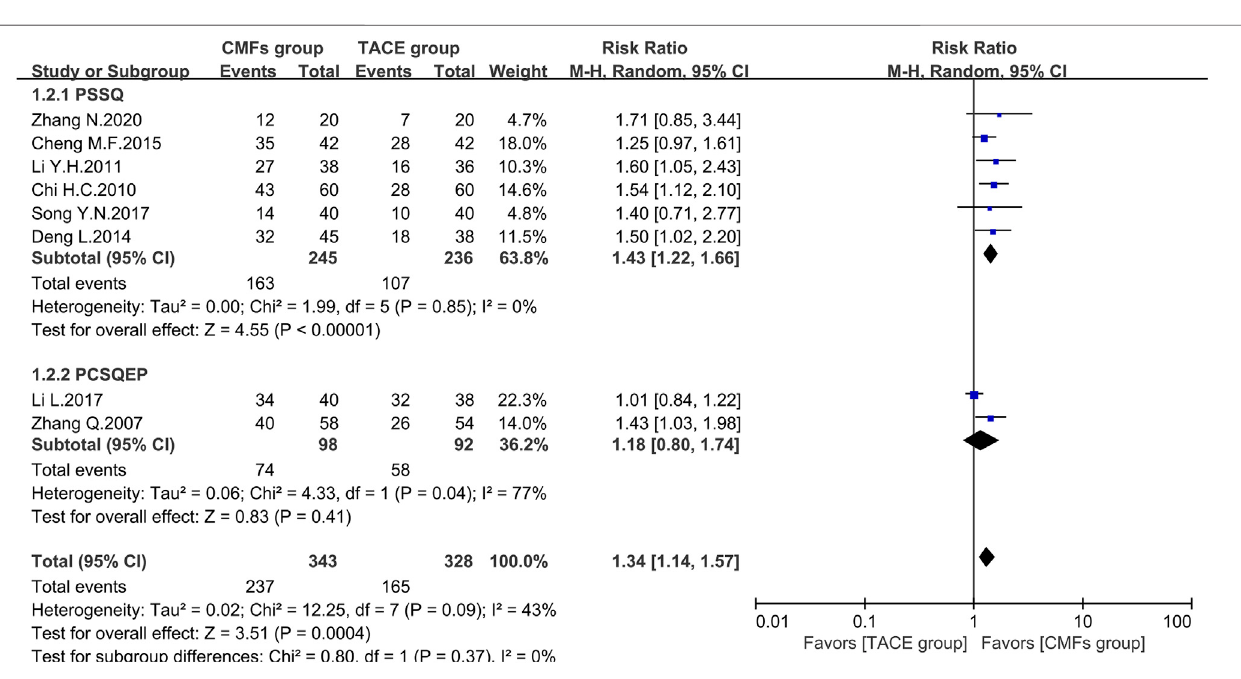
Nineteen clinical trials evaluated the ef fi cacy of solid tumors with the bene fi t of two different evaluation criteria, the determination